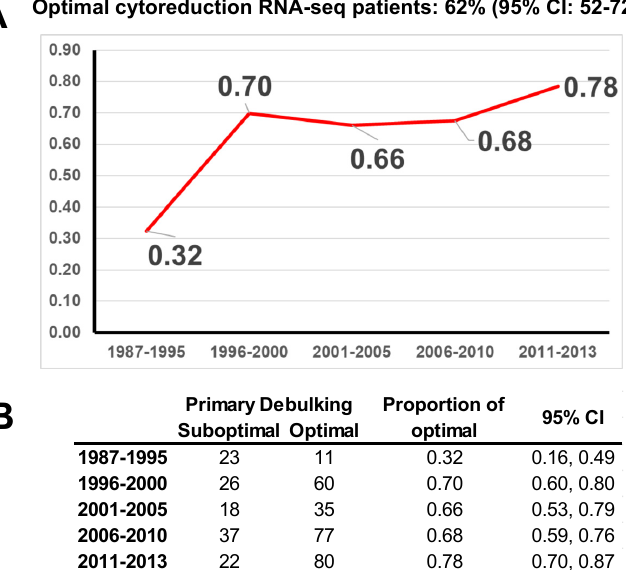
Figure 2. Patients with optimal surgical outcomes at the University of Iowa from 1987 to 2013: ( A ). There has been a steady increase in optimal surgical outcomes during the study period, probably associated with improvements in operative and perioperative care. This improvement was statistically significant ( p -value < 0.001). ( B ). Proportions and 95% confidence intervals (CI) of optimal cytoreductive surgery by calendar year intervals. In the last available interval, 78% of patients underwent optimal debulking (95% CI: 70%, 77%).